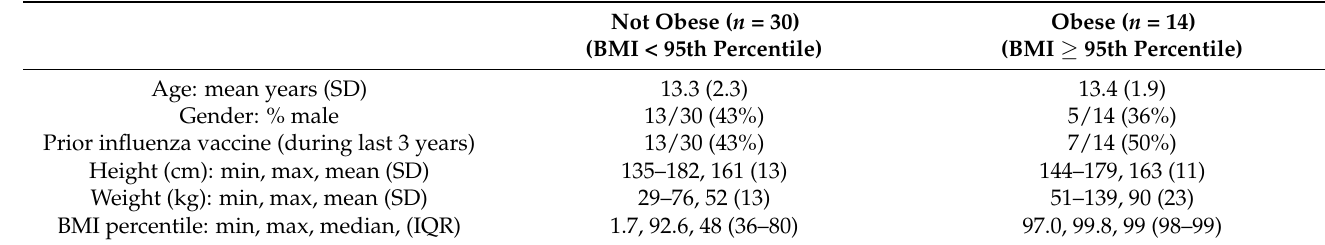
Table 1. Characteristics of study participants by BMI category.